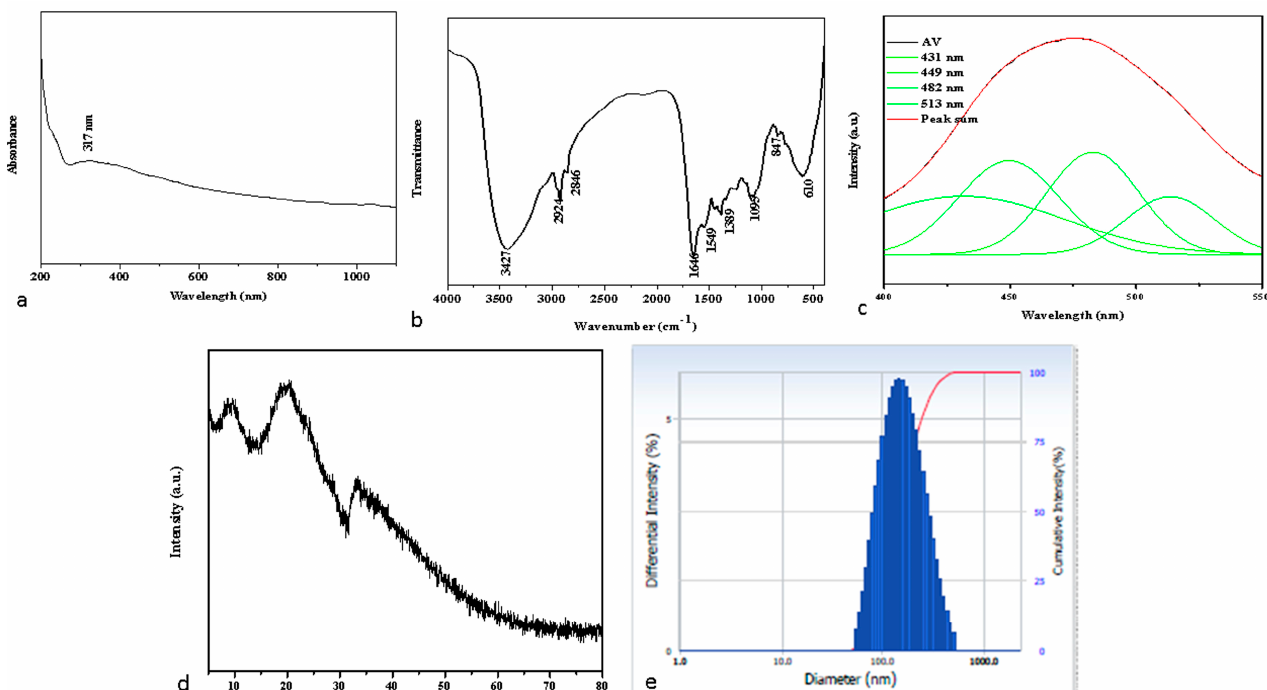
Figure 1. Characterization of albumin visnagin NPs. UV-Vis spectrophotometer ( a ), FTIR Transmit- tance vs. wavenumber chart ( b ), and PL spectrum ( c ) analysis of synthesized albumin visnagin NPs. ( d ) X-ray di ff raction Pa tt ern and ( e ) DLS spectrum of albumin visnagin NPs.